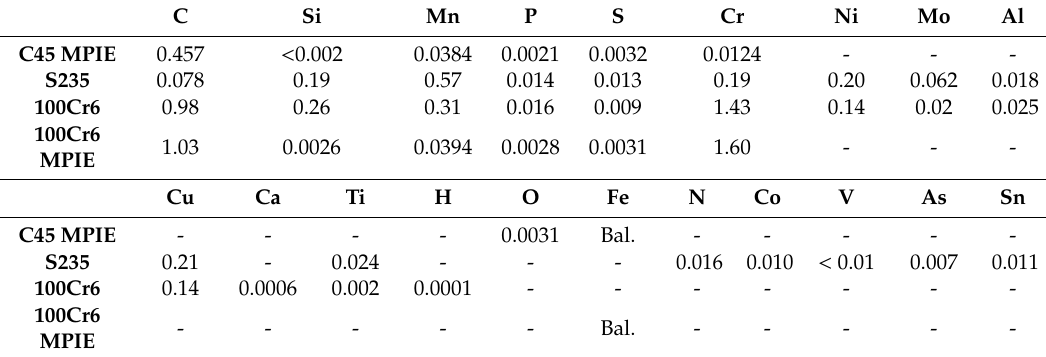
Table 1. Chemical composition in wt.% of the material investigated within this work according to